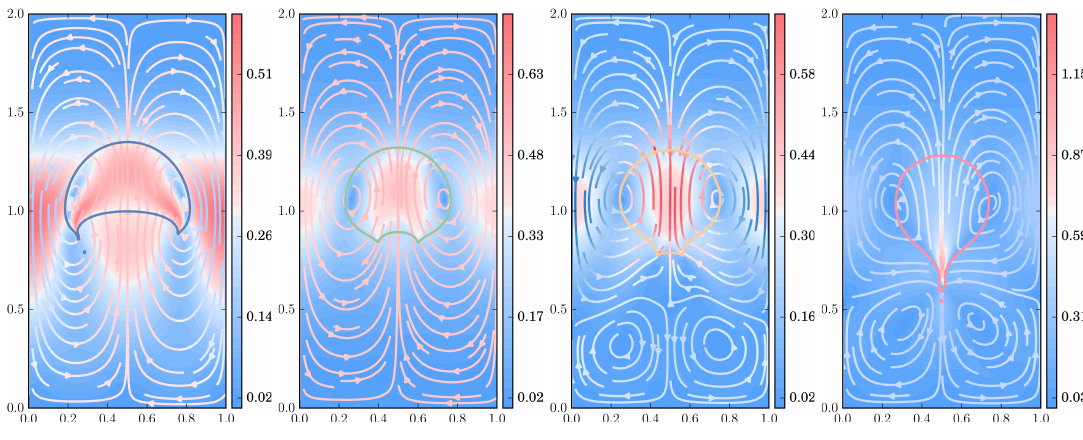
Figure 16. Drop shape and streamlines for the FENE model ( b = 50) with ρ 2 / ρ 1 = 10 − 3 , µ 2 / µ 1 = 10 − 2 , at t = 3. From left to right, c = 1, De = 1 (blue line); c = 3, De = 1 (green line); c = 5, De = 3 (yellow line); and c = 9, De = 5 (red